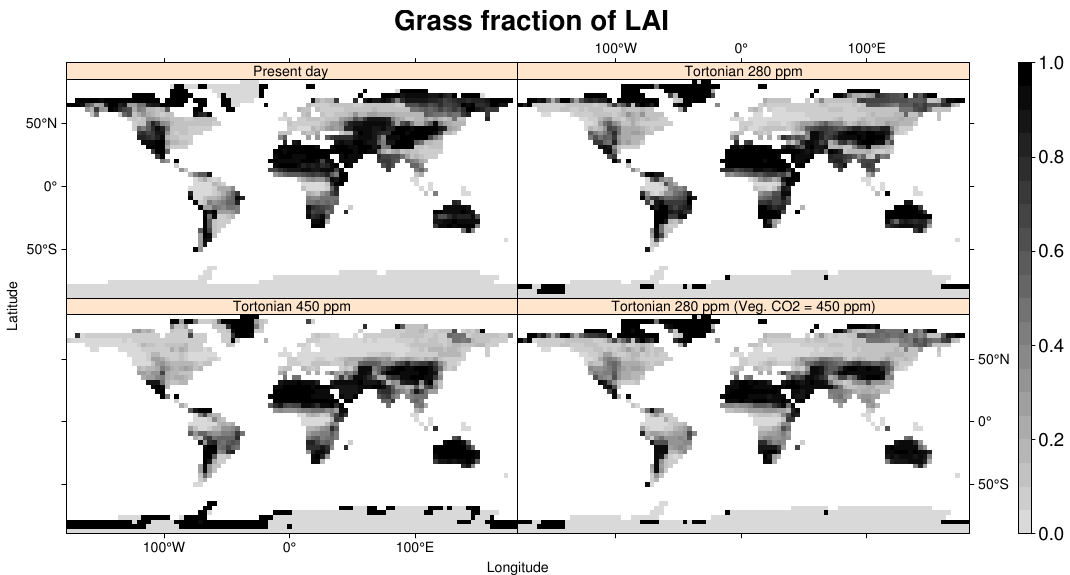
Figure 3. Modelled grass fraction of leaf area index (LAI) for present-day simulation, Tortonian 280ppm CO 2 , and Tortonian 450ppm CO 2 concentrations, respectively. Shown also is the grass fraction of LAI for a mixed CO 2 forcing in climate and vegetation model. seasonal forests in Europe is not well-supported by palaeob- otanical proxy data. All of their simulations show a greater extent of the boreal forest than in either in Pound et al. (2011) or our